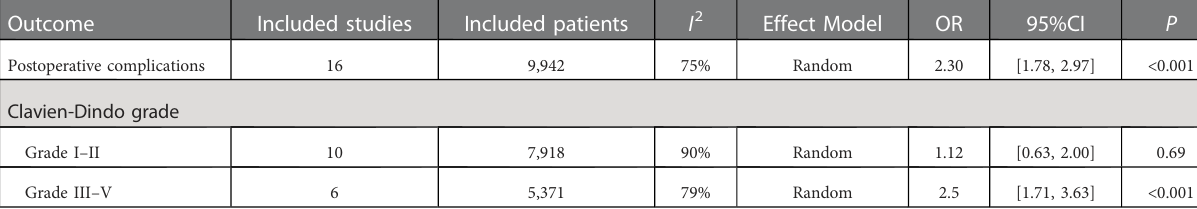
TABLE 2 Analysis of postoperative complications between the PBT group and not-PBT